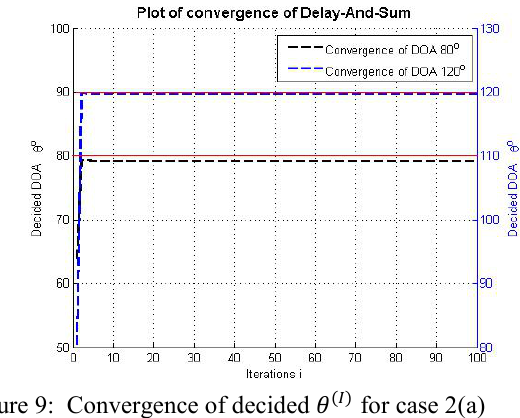
for case 2(a) ( 𝐼 ) 𝜃